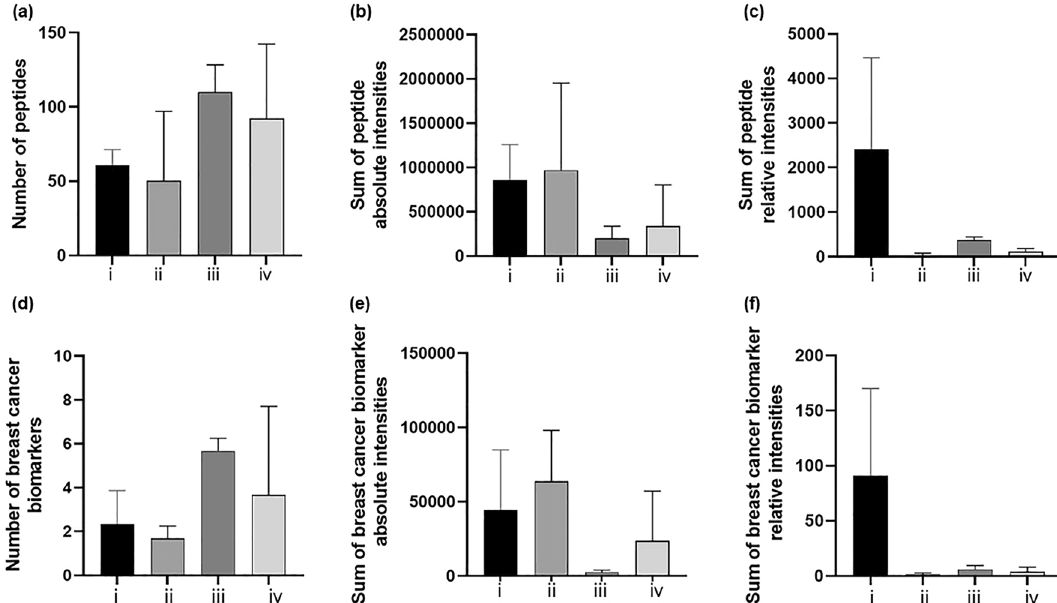
Figure 4. Column graph showing the number, the absolute and relative intensities of either all detected peptides peaks ( a , b , c , respectively), or of potential breast cancer biomarkers ( d , e , f , respectively) in fingermarks incubated for 2 h at 50 °C in Tupperware box, containing a saturated solution of K 2 SO 4 , after spotting them with a 20 μg/mL trypsin solution in 50 mM NH 4 HCO 3 buffer containing either Set (vi) -RapiGest SF 0.1% (w/v); Set (ii) —RapiGest SF 0.2% (w/v); Set ( iii)— MEGA-8 2% (w/v); Set (iv)— a mixture of 2% (w/v) MEGA-8 and 0.1% (w/v) RapiGest SF . For relative intensities calculation, peptides intensities were normalised against the autolysis fragment of trypsin at m/z